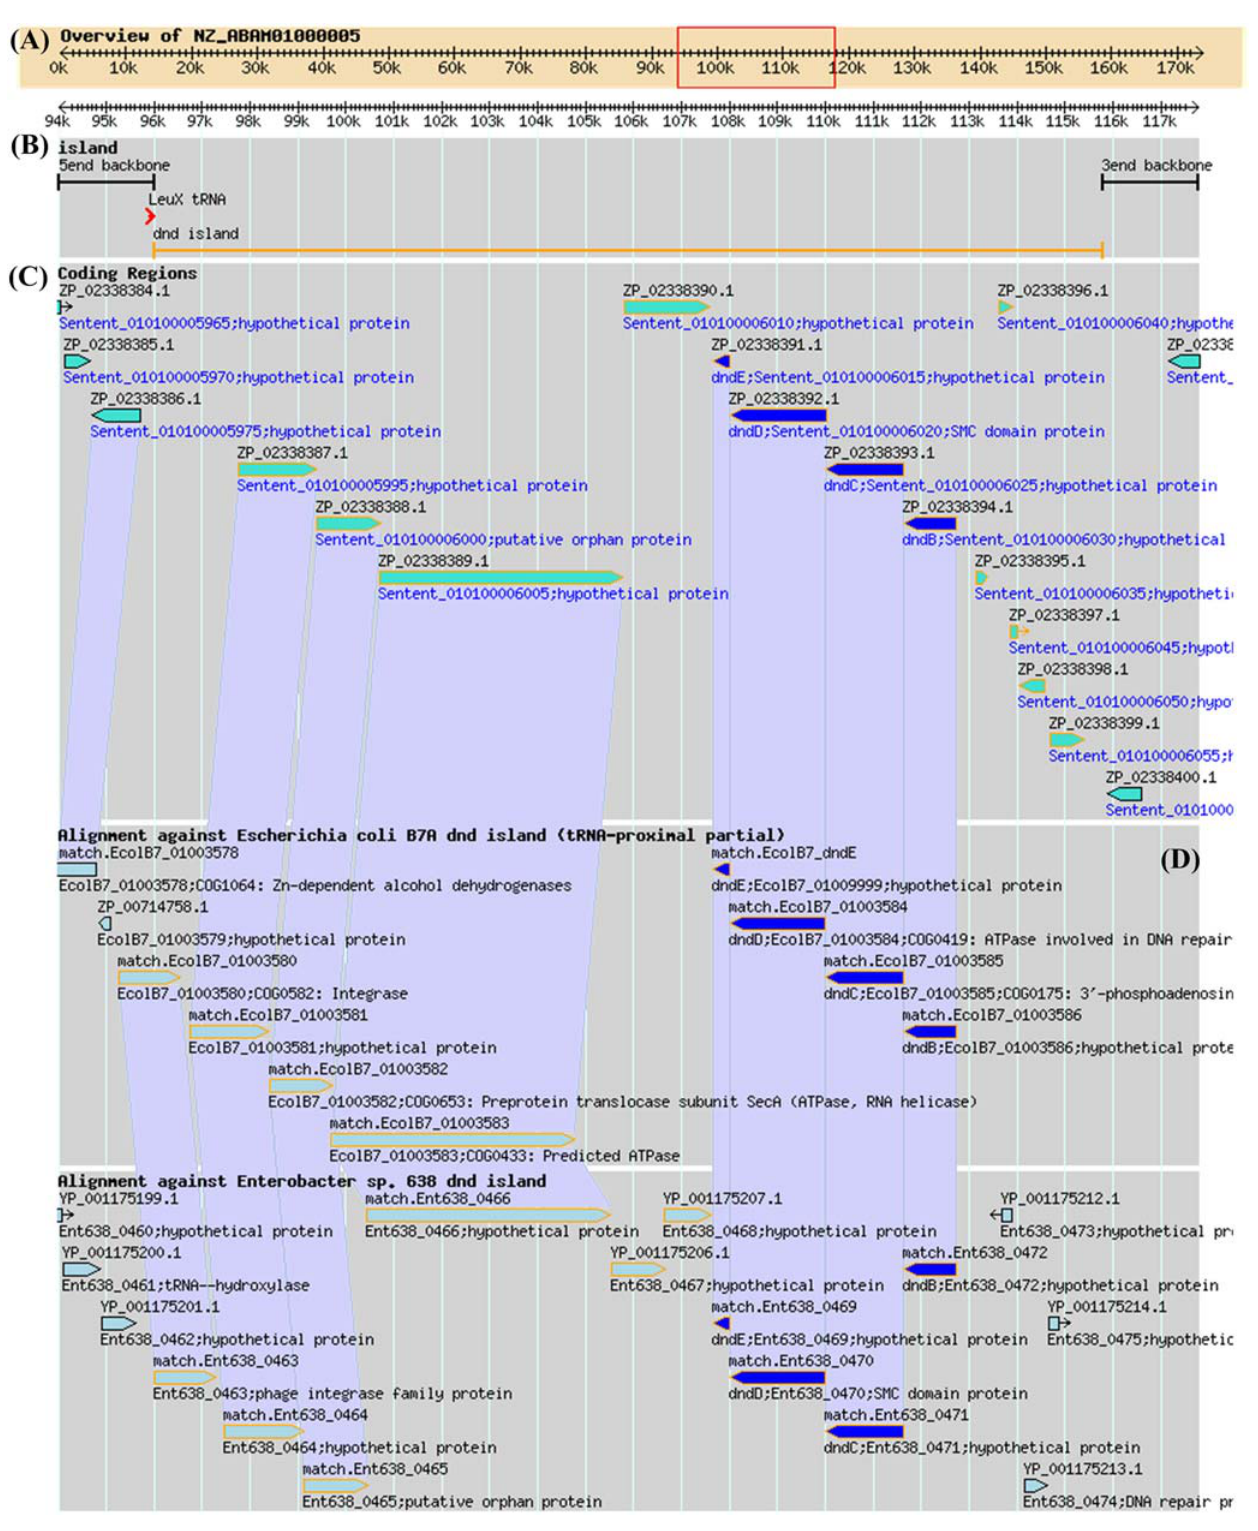
Figure 2. The dnd island in the Salmonellaenterica serovar Saintpaul SARA23 genome that is currently being sequenced. ( A ) The top axis corresponds to the dnd island-bearing contig (NCBI Refseq accession no. NZ_ABAM01000005), while the lower axis represents a magnified view of the region shown in the red box. The symbol ‘k’ in the coordinates denotes kilobase pairs. ( B ) A schematic view of the lower axis (above) illustrating the location of the 19.7-kb dnd island (orange line), the leuX tRNA gene integration site (red arrow head), and the upstream/downstream flanking regions (black lines) that are conserved across 14 completely sequenced Salmonella enterica genomes. The ‘5end’ and ‘3end’ backbone labels refer to the 5 9 - and 3 9 -flanking backbone segments in relation to the orientation of the leuX tRNA gene, respectively. ( C ) SynView-facilated synteny mapping of the dnd islands and immediate flanking sequences from three species: Salmonella enterica serovar Saintpaul SARA23 (19.7-kb island)